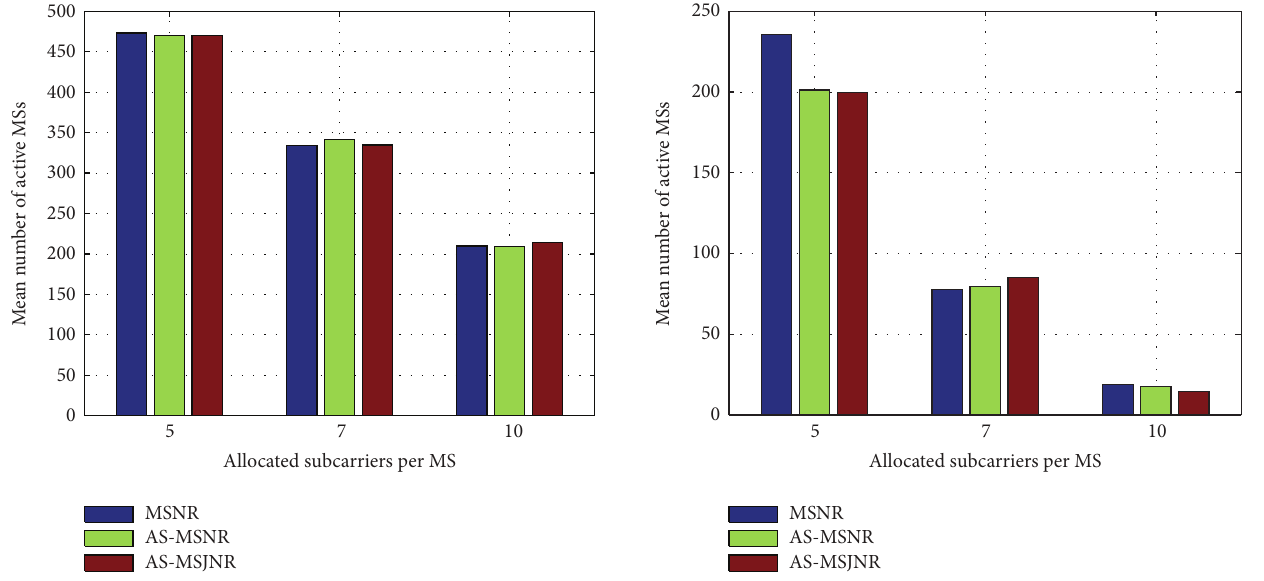
Figure 4: Mean number of active MSs for QPSK modulation and one tier of cells around the central cell.